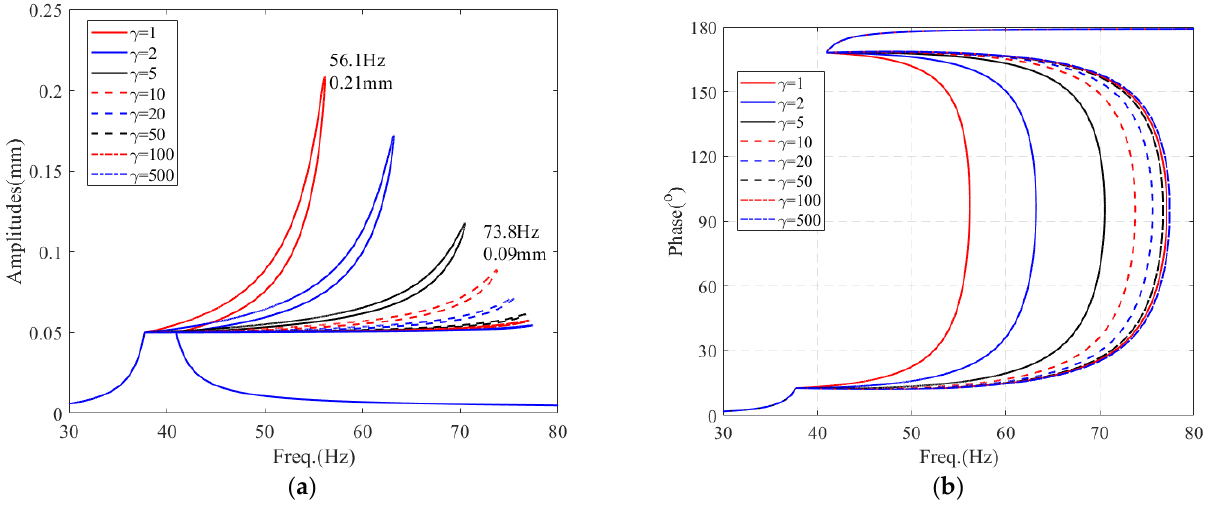
Figure 24. Influences of γ on amplitude – frequency and phase – frequency characteristics of 3# shaft: